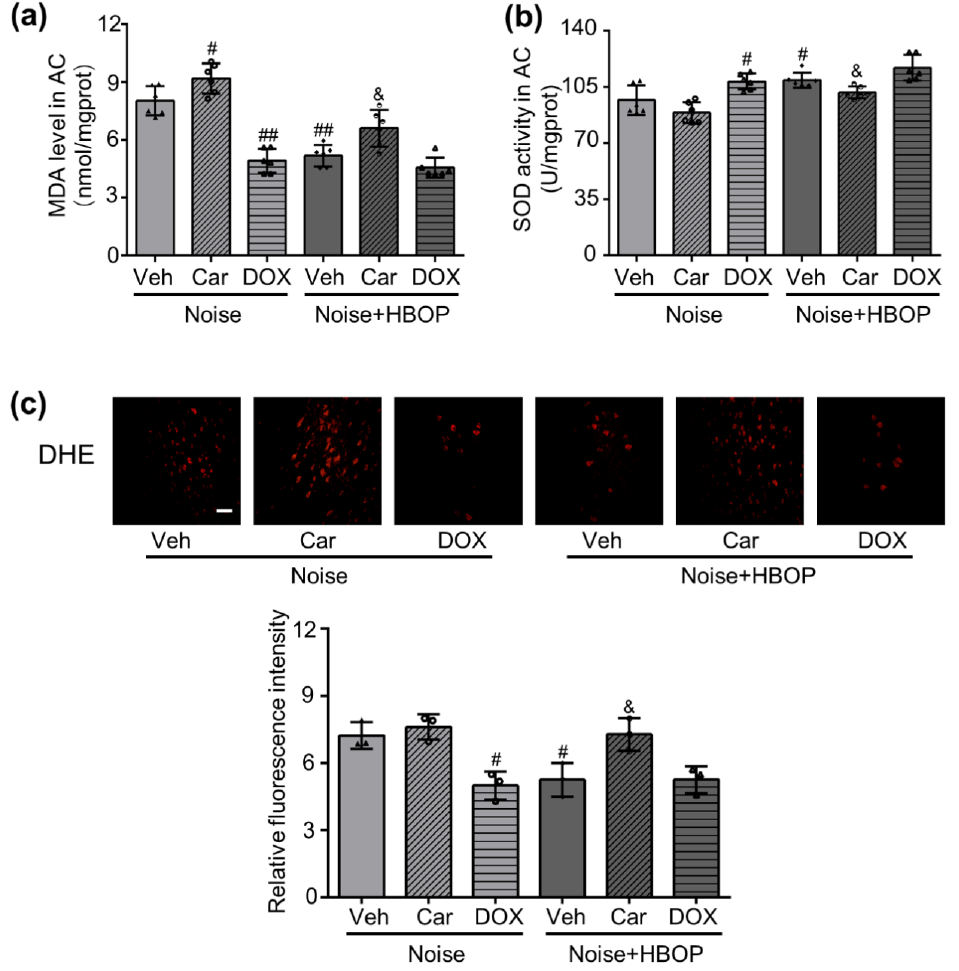
Figure 5. Summarized data showing malonaldehyde (MDA) content ( a ) and superoxide dismutase (SOD) activity ( b ), original micrographs and analyzed data ( c ) on superoxide-sensitive dihydroethidium (DHE) fluorescence in auditory cortex of mice from Noise or HBOP group treated with Veh, Car, or DOX detected by colorimetric ( a , b ) or fluorescence staining ( c ) assay. Magnification × 400, scale bar = 50 µ m. Data are shown as means ± SD, n = 6 in colorimetric assay, n = 3 in fluorescence staining, ## P < 0.01, # P < 0.05 vs Noise, & P < 0.05 vs. HBOP. All individual data points were shown in the figure